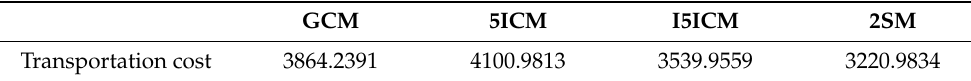
Table 10. The transportation costs of the four